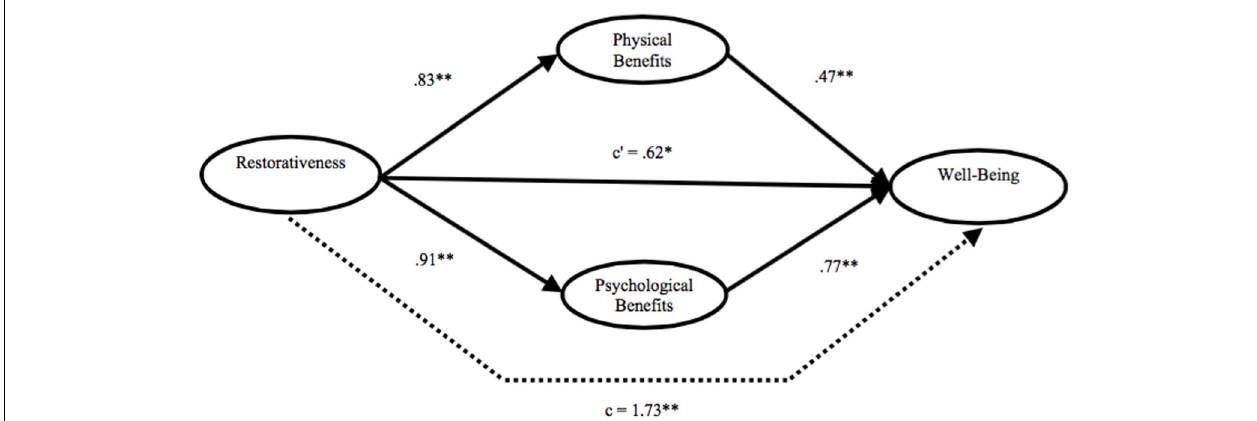
FIGURE 2 | Mediating model which shows the effect of restorativeness on well-being after the visit through physical and psychological benefits felt during the visit. NOTE: Path values represent unstandardized regression coefficients. The (c ∗ ) value represents the effect, from bootstrapping analyses, of the restorativeness on well-being after the mediators are included. Dotted line (c) represents the total effect of the restorativeness on well-being prior to the inclusion of the mediating variables. ∗ p < 0.05; ∗∗ p < 0.001.